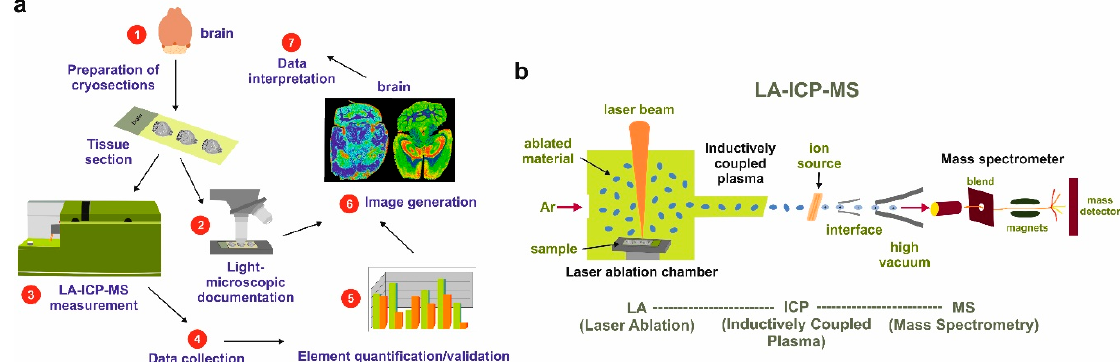
Figure 3. Simplified laser ablation inductively coupled plasma mass spectrometry imaging (LA-ICP-MSI) workflow. ( a ) LA-ICP-MSI of a tissue sample requires seven sequential steps, including (1) the preparation of a cryosection from a specimen, (2) light-microscopic documentation of the section, (3) ablation of biological material and element measurement, (4) data collection, (5) calculation of relative or absolute element concentrations, (6) production of elements maps, and finally (7) interpretation of the LA-ICP-MSI results. ( b ) For the LA-ICP-MSI measurement, the sample is positioned in the laser ablation (LA) chamber containing a mobile sample tray enabling line-by-line scans in all directions. Simplified, a focused laser beam ablates biological material, which is transported in an inert carrier gas stream into the inductively coupled plasma (ICP). There the sample is decomposed into its constituent elements and transformed into ions by electromagnetic induction. The ions are subsequently transferred into a high vacuum mass spectrometry (MS) analysis chamber and identified according to their mass/charge ( m/z ) ratio. The concentration of each element is directly correlated to the signal intensities.